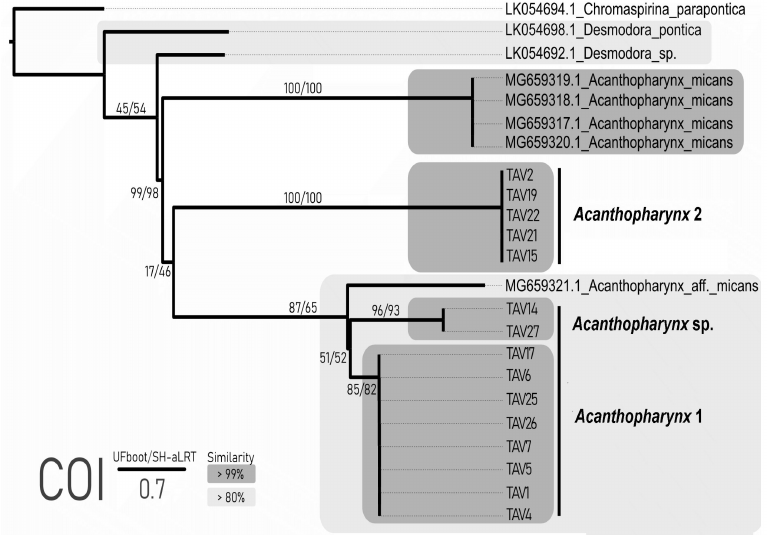
Figure 5. COI ML Phylogenetic tree. Branches are shown with the UFboot/SH-aLRT support. The sequences with similarities ≥ 80% and 90% are indicated with light and dark